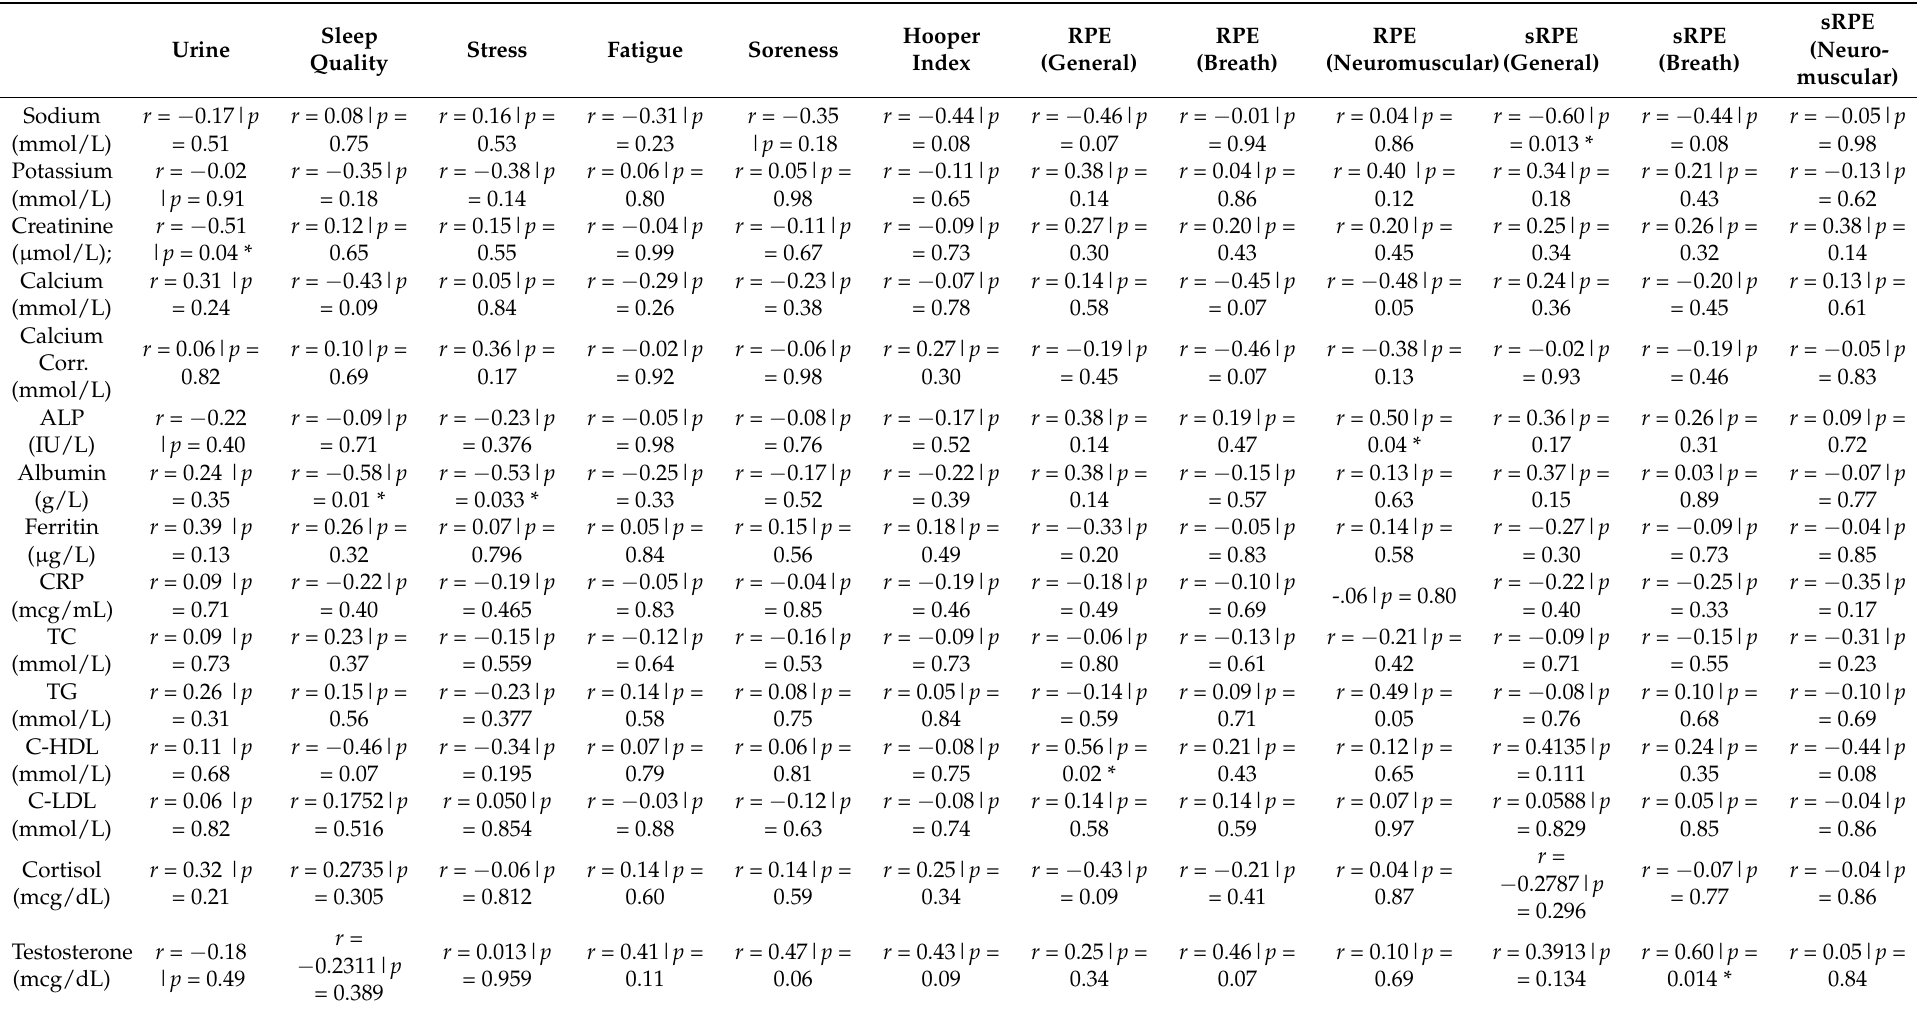
Table 5. Pearson correlations between percentage change of BcP (before and after the pre-seasonand percentage change of training loads (before and after the pre-season). Sleep Urine Stress Fatigue Soreness Quality